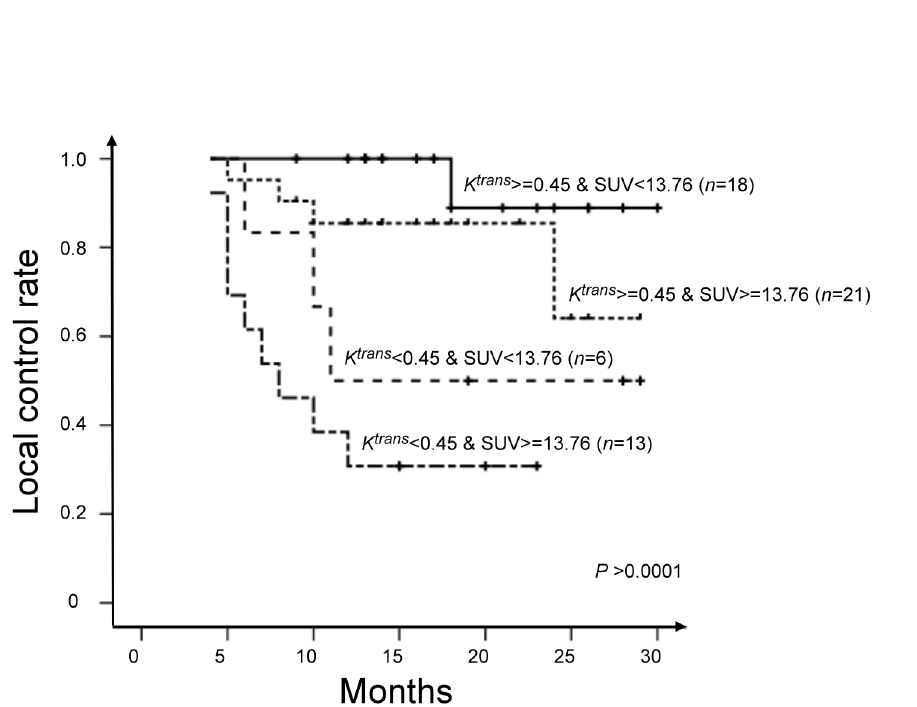
Figure 7. Subgroup analysis of local control rates according to different combinations of K trans (cut-off = 0.45 min -1 ) and SUV (cut-off = 13.76 max